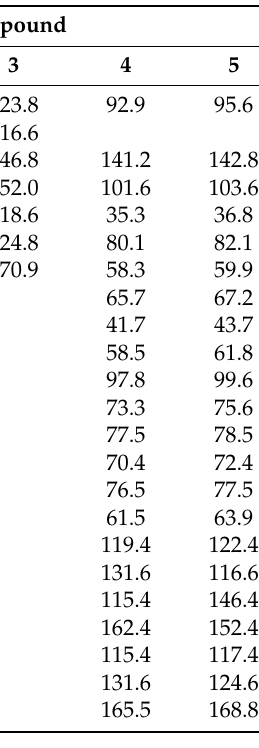
Table 2. 13 C-NMR (100 MHz, DMSO- d 6 ) of the five compounds.